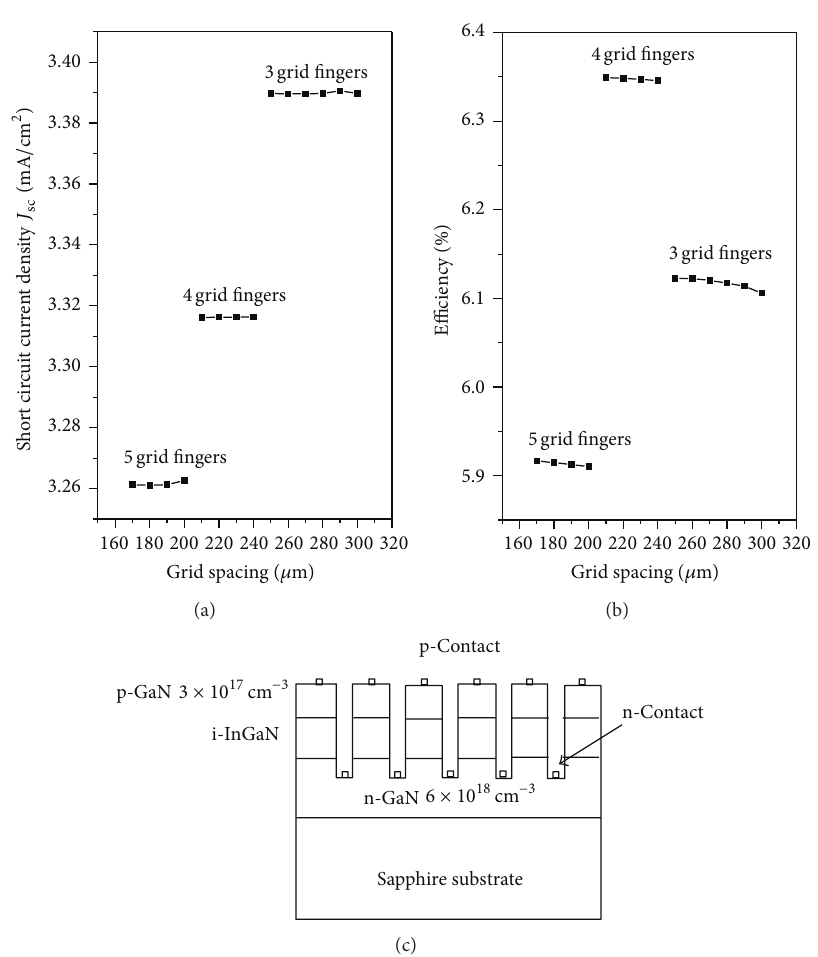
Figure 5: Effect of (a) short circuit current density, (b) efficiency on grid spacing for different number of grids, and (c) p-i-n InGaN/GaN double heterojunction solar cell with grid type